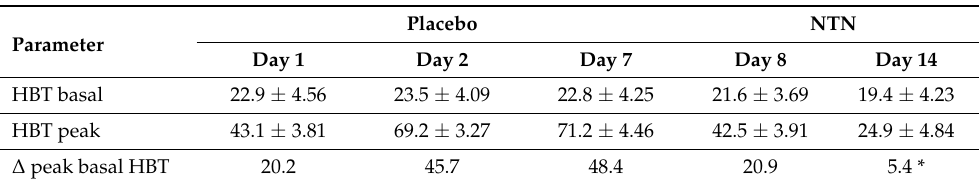
Table 3. Evolution of the hydrogen breath test in patients receiving placebo on Days 1–7 with crossover to NTN on Days